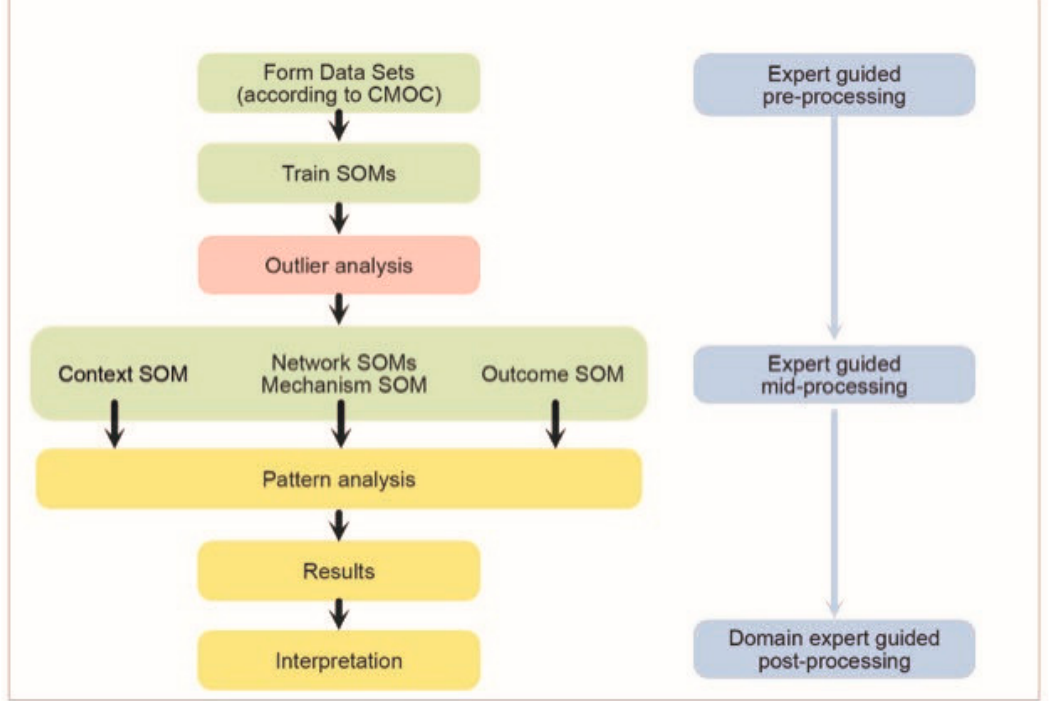
Figure 2. The SOMNet ( left ) and EbCA ( right ) analysis procedure applied to this study.